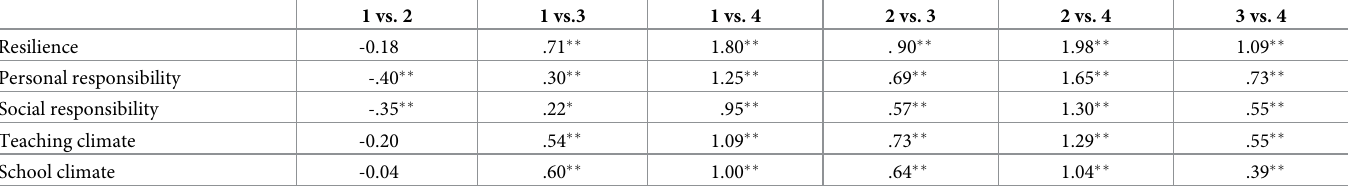
Table 4. Multiple comparisons